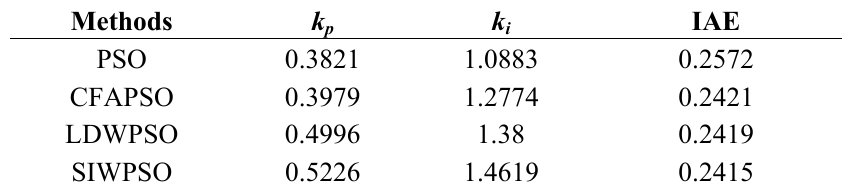
Table 4. The IAE values obtained by Equation (13) for each iteration of the four PSO methods.